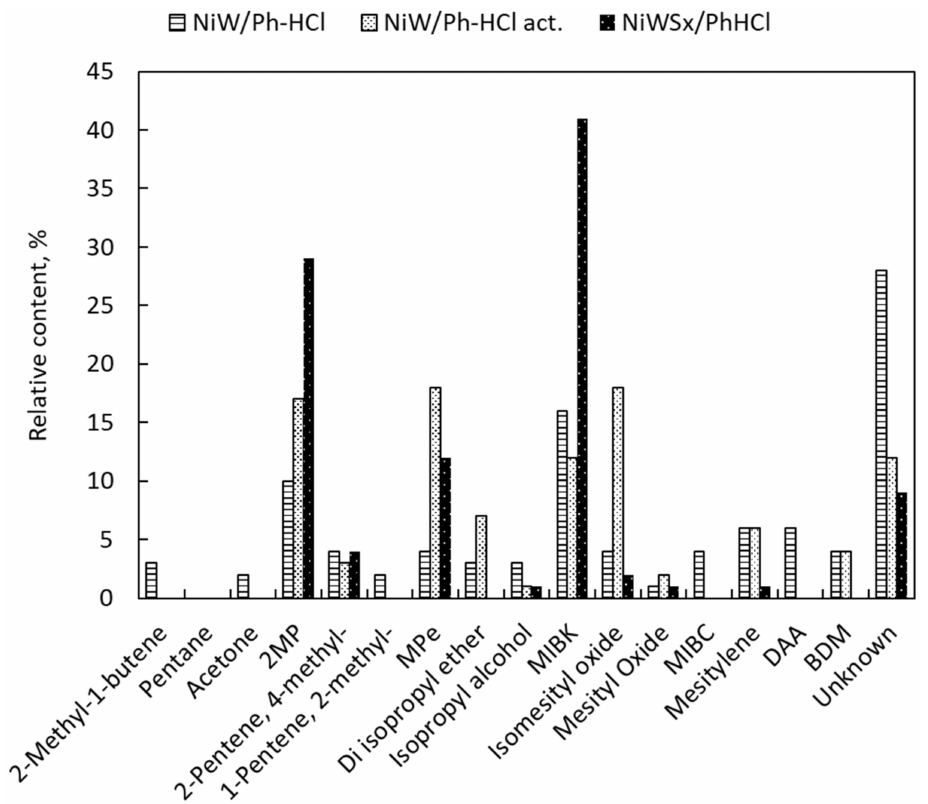
Figure 7. Compounds present in the organic phase of liquid product for the tests using NiW/Ph-HCl type catalysts. NiW/Ph-HCl catalyst was used directly, NiW/Ph-HCl catalyst was previously reduced in hydrogen atmosphere and NiWSx/Ph-HCl material was previously treated for the sulfidation of the metal oxides. BDM abbreviation refers to benzene, 1,4-dimethyl-2-(2-methylpropyl)-.